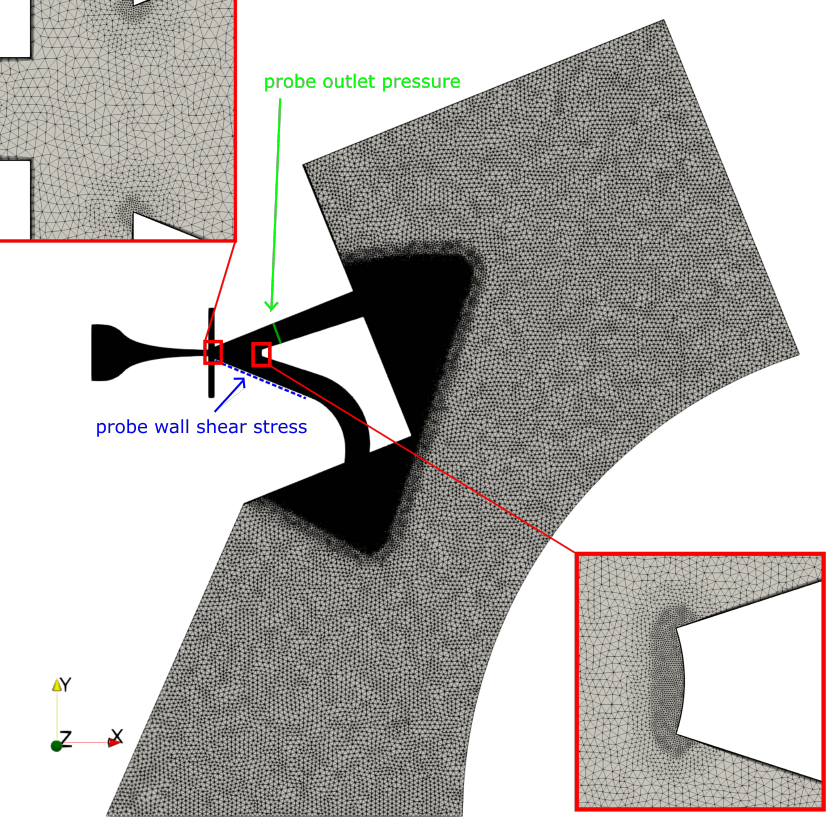
Figure 4. 2D unstructured Mesh for the parametric simulation with 355.432 nodes and data probes for the